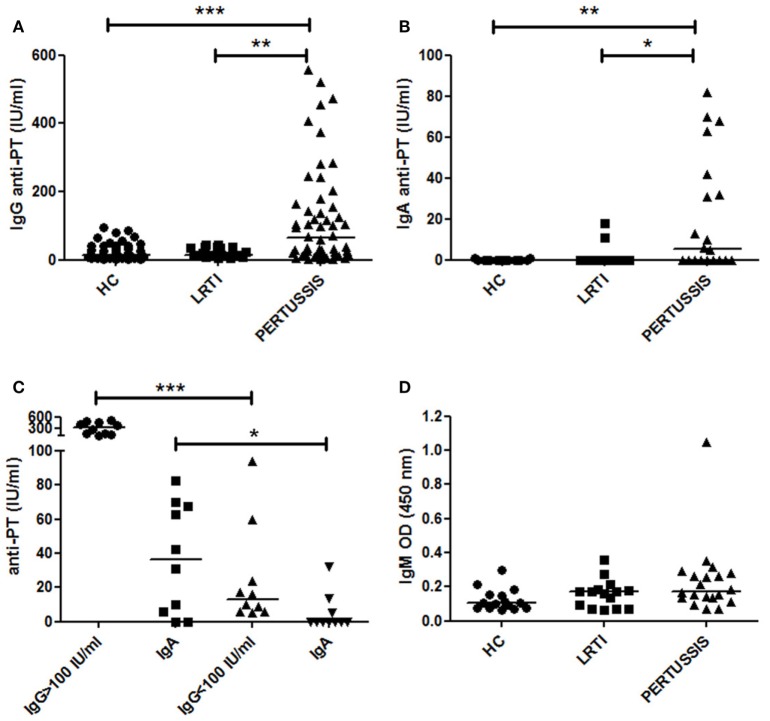
Anti-PT-specific Ig in the serum. (A,B) The plot shows the concentration of specific anti- pertussis toxin-specific IgG (PT-IgG) or pertussis toxin-specific IgA (PT-IgA) in the serum of control [healthy controls (HC) and lower respiratory tract infections (LRTI)] and PERTUSSIS mothers. (C) The plot shows the concentration of specific anti-PT-IgA in the serum of PERTUSSIS mothers with anti-PT-IgG ≥ 100 IU/mL or with anti-PT-IgG < 100 IU/mL. (D) Optical density value of IgM in the serum of control (HC and LRTI) and PERTUSSIS mothers. Statistical significance was determined using the Mann–Whitney test; *p < 0.05, **p < 0.01, and ***p < 0.001. A total of 50 HC, 17 LRTI, and 57 PERTUSSIS samples could be evaluated for IgG. A total of 15 HC, 15 LRTI, and 20 PERTUSSIS samples could be evaluated for IgA and IgM.